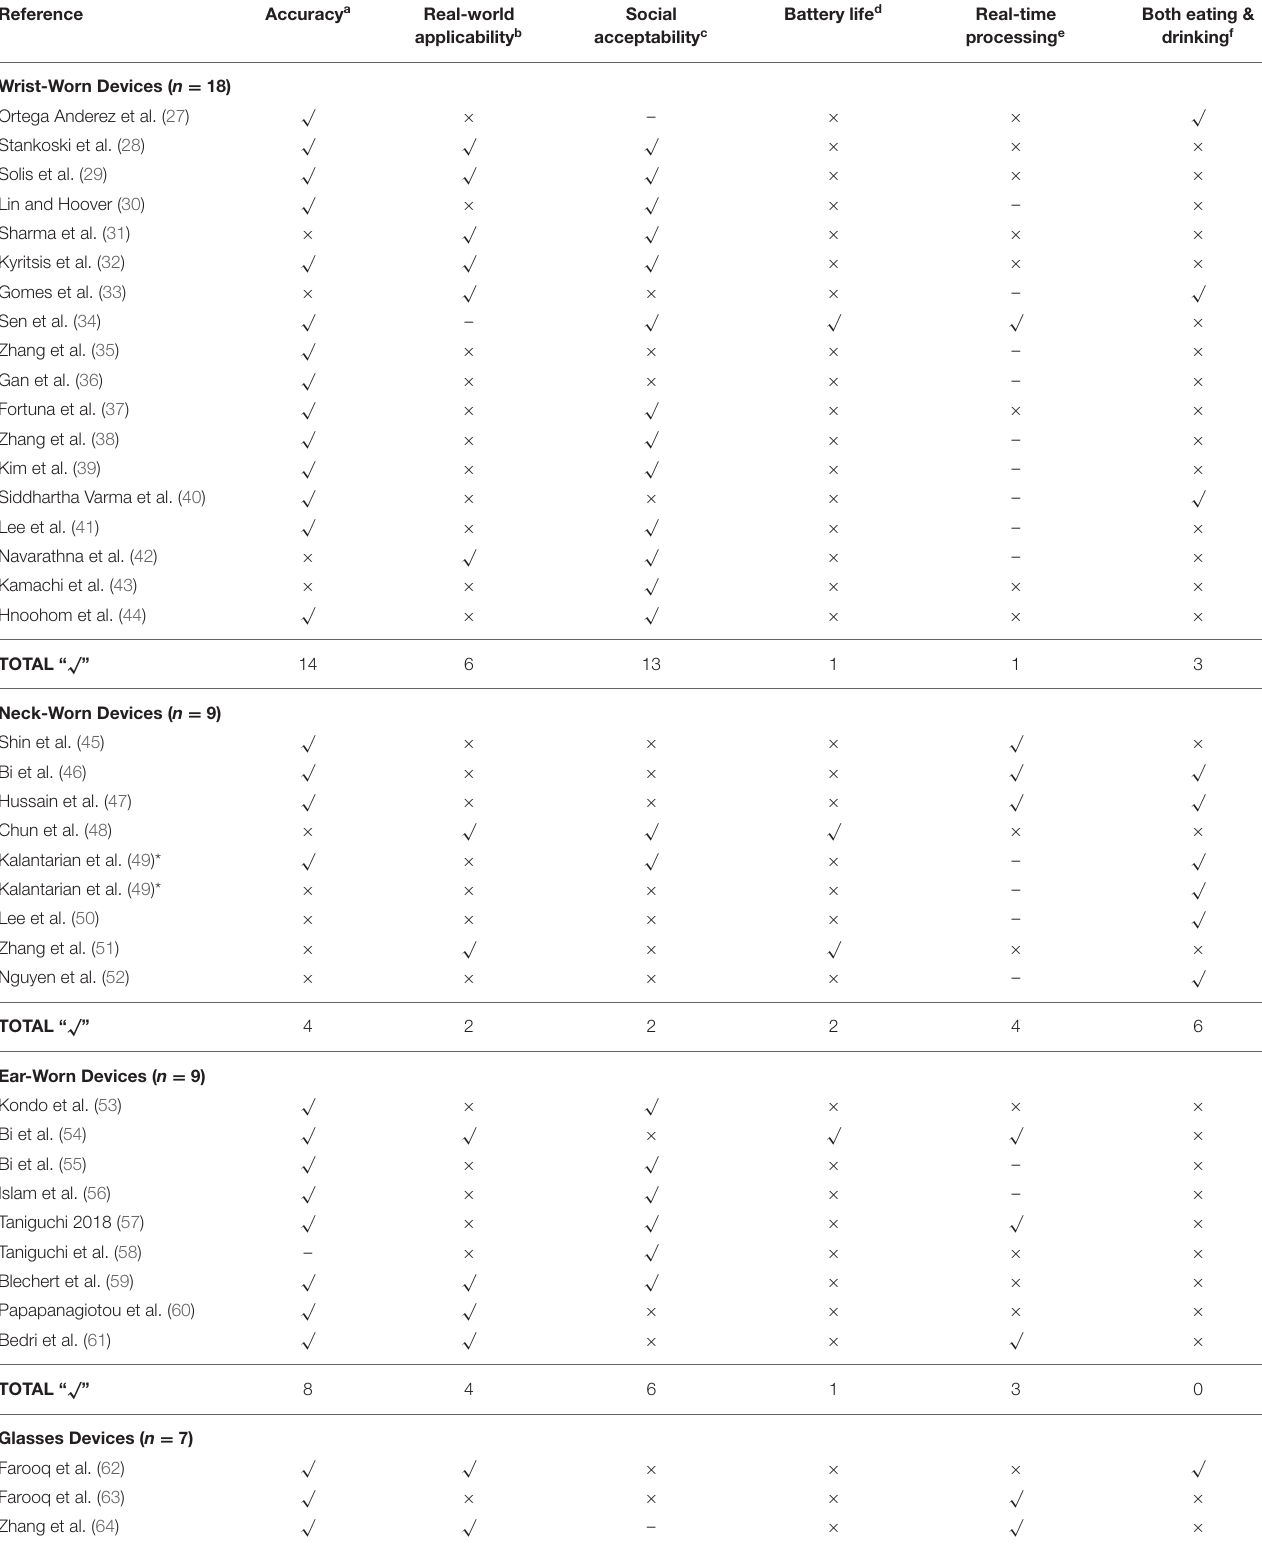
TABLE 2 | An overview of all identified devices compared with the five feasibility criteria used to determine suitability for use by dietitians in real-world